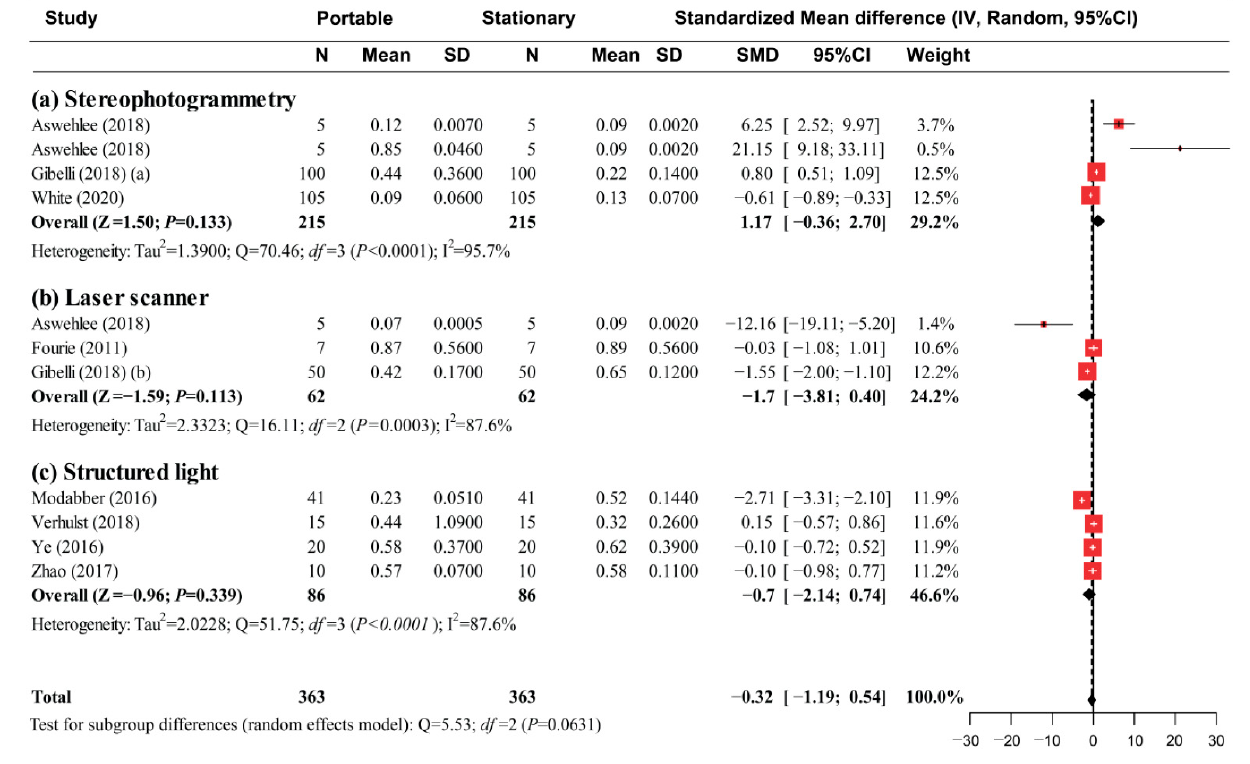
Figure 4. Meta-analysis results of the subgroup analysis. ( A ) Stereophotogrammetry; ( B ) laser scanner; ( C ) structured light.